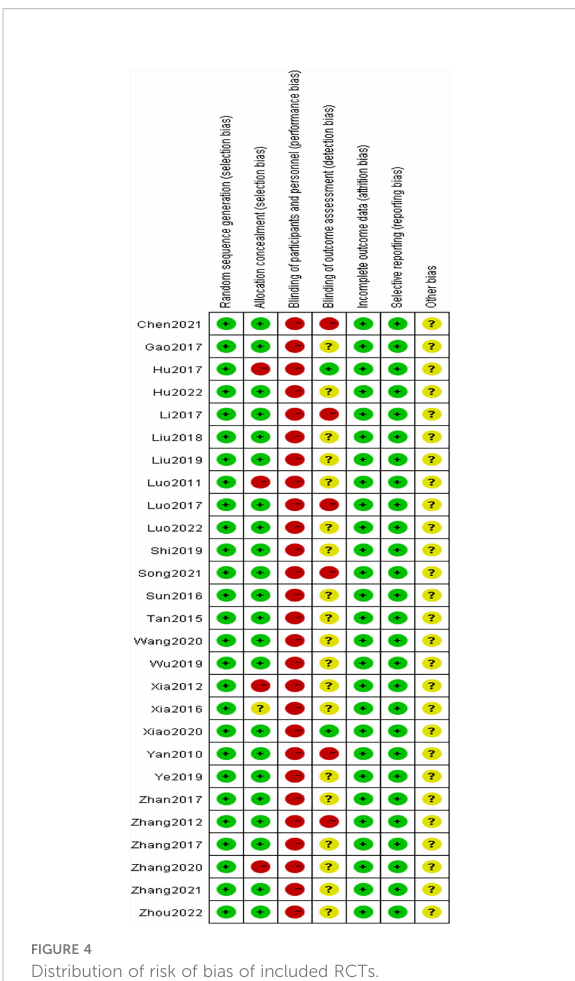
FIGURE 4 Distribution of risk of bias of included RCTs.